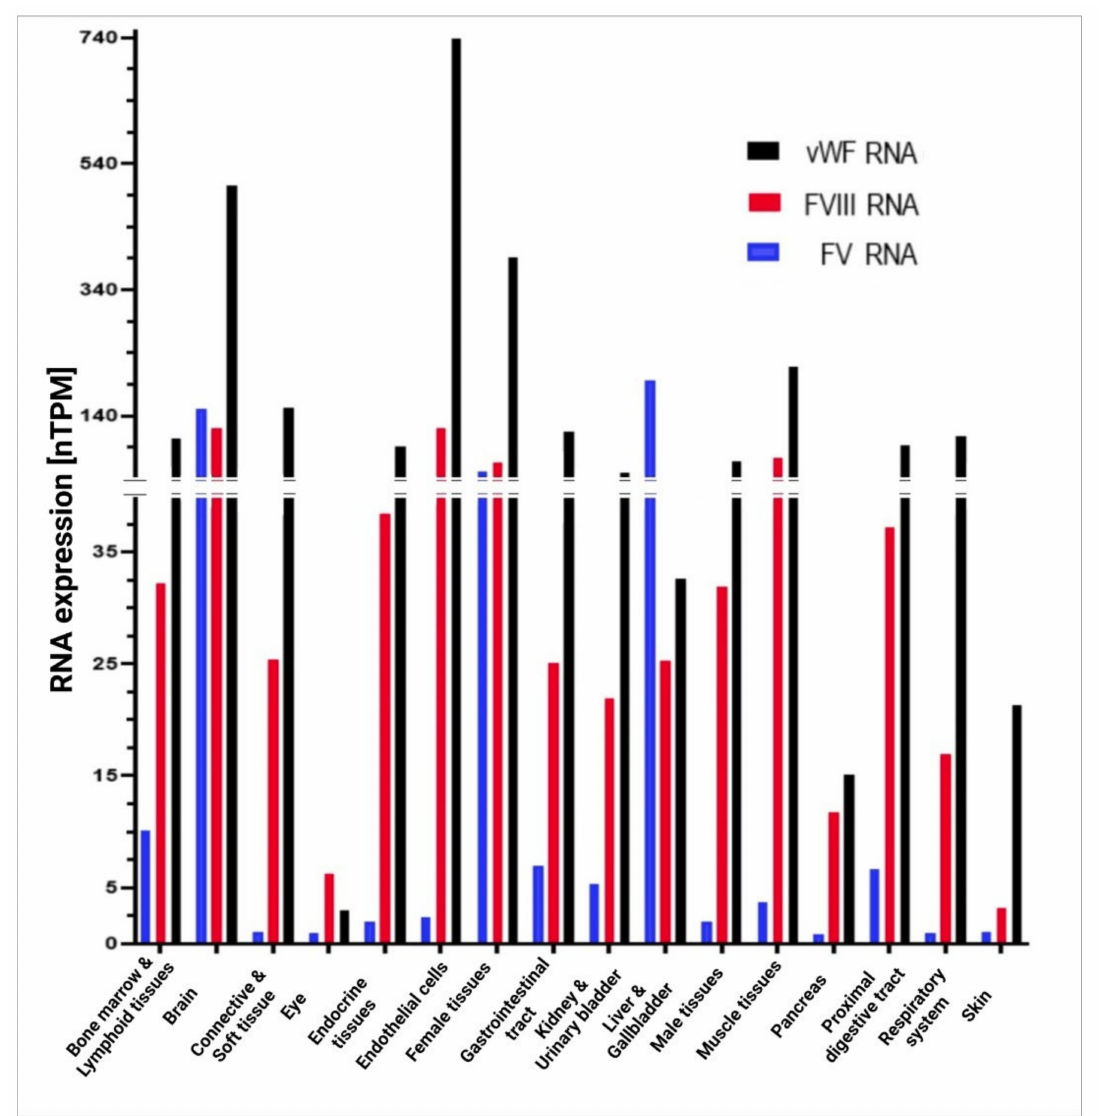
Figure 6. In vivo RNA expression for vWF, FVIII, and FV in different organs and tissues, according to the classification provided by the Human Protein Atlas. Tissues were grouped into organs, such as the bone marrow and lymphoid tissues (appendix, lymph node, spleen, thymus, tonsil), the brain (amygdala, basal ganglia, thalamus, midbrain, pons, medulla oblongata, hippocampal formation, spinal cord, white matter, cerebral cortex, cerebellum, choroid plexus, hypothalamus), connective and soft tissue (soft tissue, adipose tissue), the eye (retina), endocrine tissues (thyroid gland, parathyroid gland, adrenal gland, pituitary gland), female tissues (vagina, breast, cervix, endometrium, fallopian tube, ovary, placenta), the gastrointestinal tract (stomach, colon, duodenum, rectum, small intestine), kidneys and the urinary bladder, the liver and the gallbladder, male tissues (testis, epididymis, prostate, seminal vesicle), muscle tissues (heart muscle, skeletal muscle, smooth muscle), the pancreas, the proximal digestive tract (oral mucosa, salivary gland, esophagus, tongue), the respiratory system (nasopharynx, bronchus, lung), and the skin. nTPM, normalized protein- coding transcripts per million; vWF, von Willebrand factor; FVIII, factor VIII; FV, factor V. Created with GraphPad Prism 8 software (GraphPad Software, La Jolla, CA,